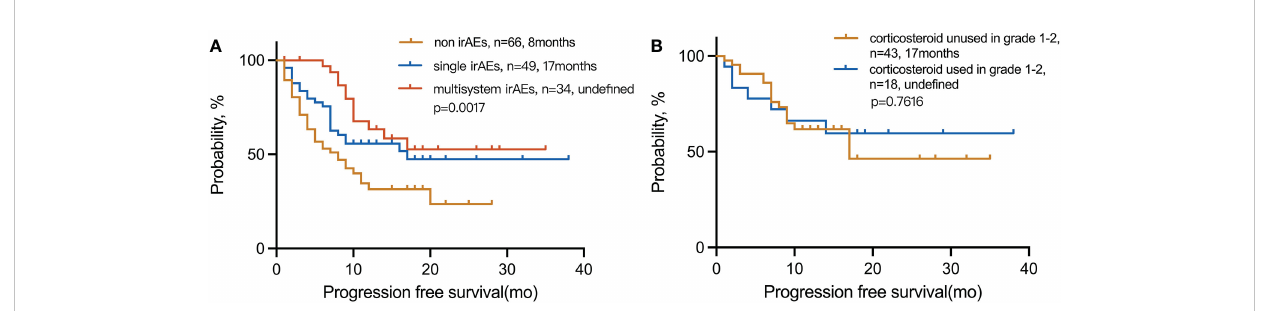
FIGURE 6 Kaplan – Meier curves for PFS in (A) patients with multisystem irAEs compared to patients with single irAEs and non-irAEs and (B) patients with irAEs in grades 1 – 2 used corticosteroid compared to unused. irAEs, immune-related adverse events.